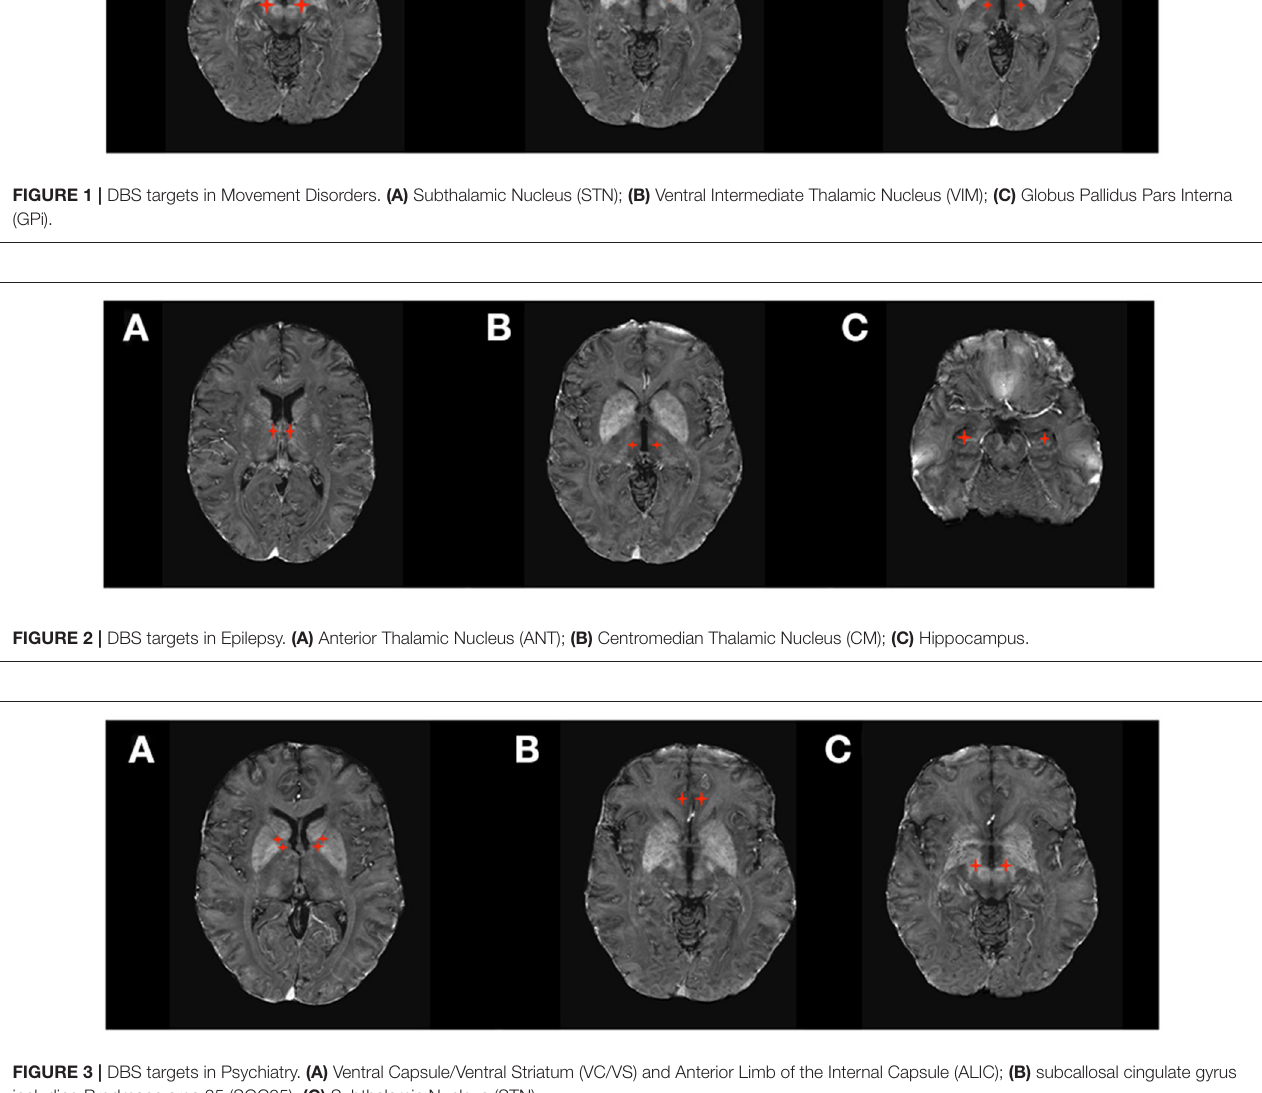
Frontiers in Neurology |